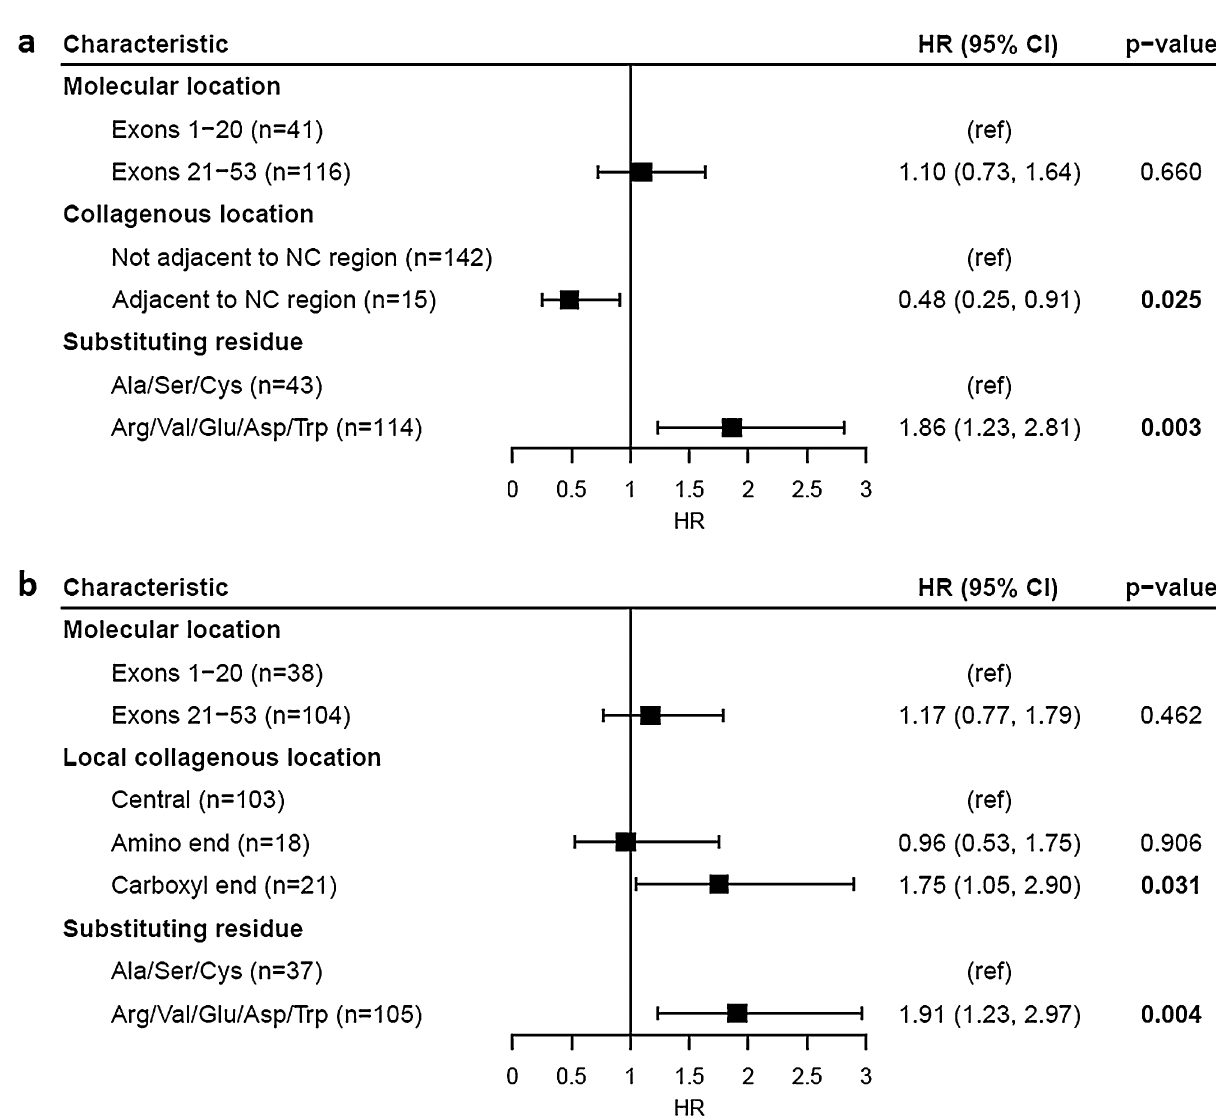
( b ) excluding NC boundary Gly variants (overall significance of model, p = 0.014). HR (95% CI), Hazard ratio (95% confidence interval); NC, non-collagenous; ref, Reference